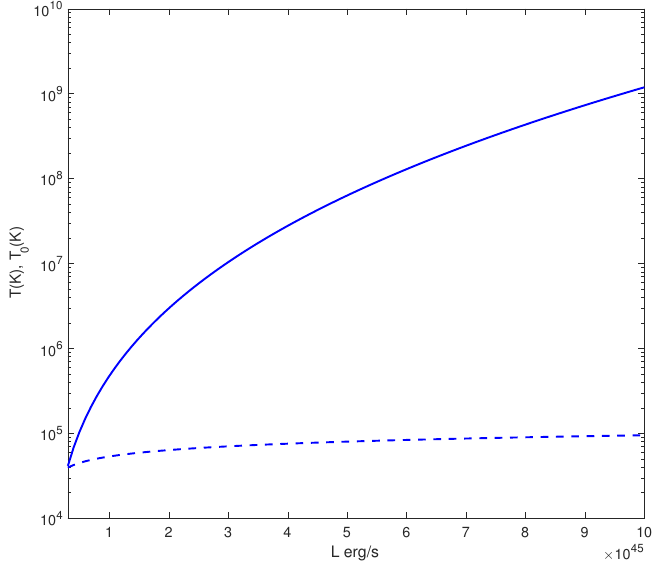
Figure 1. Behavior of T (solid line) and T 0 (dashed line) with respect to the bolometric luminosity of AGN. The set of parameters is: a = 1, (cid:101) = 0.1, κ = 0.5, M 8 = 1, γ 1 = 7 × 10 3 , γ 2 = 10 4 and R 0 ≈ 0.01